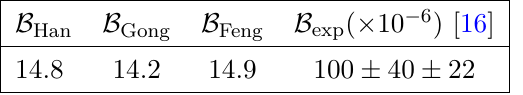
Table 4 . Branching ratios of B